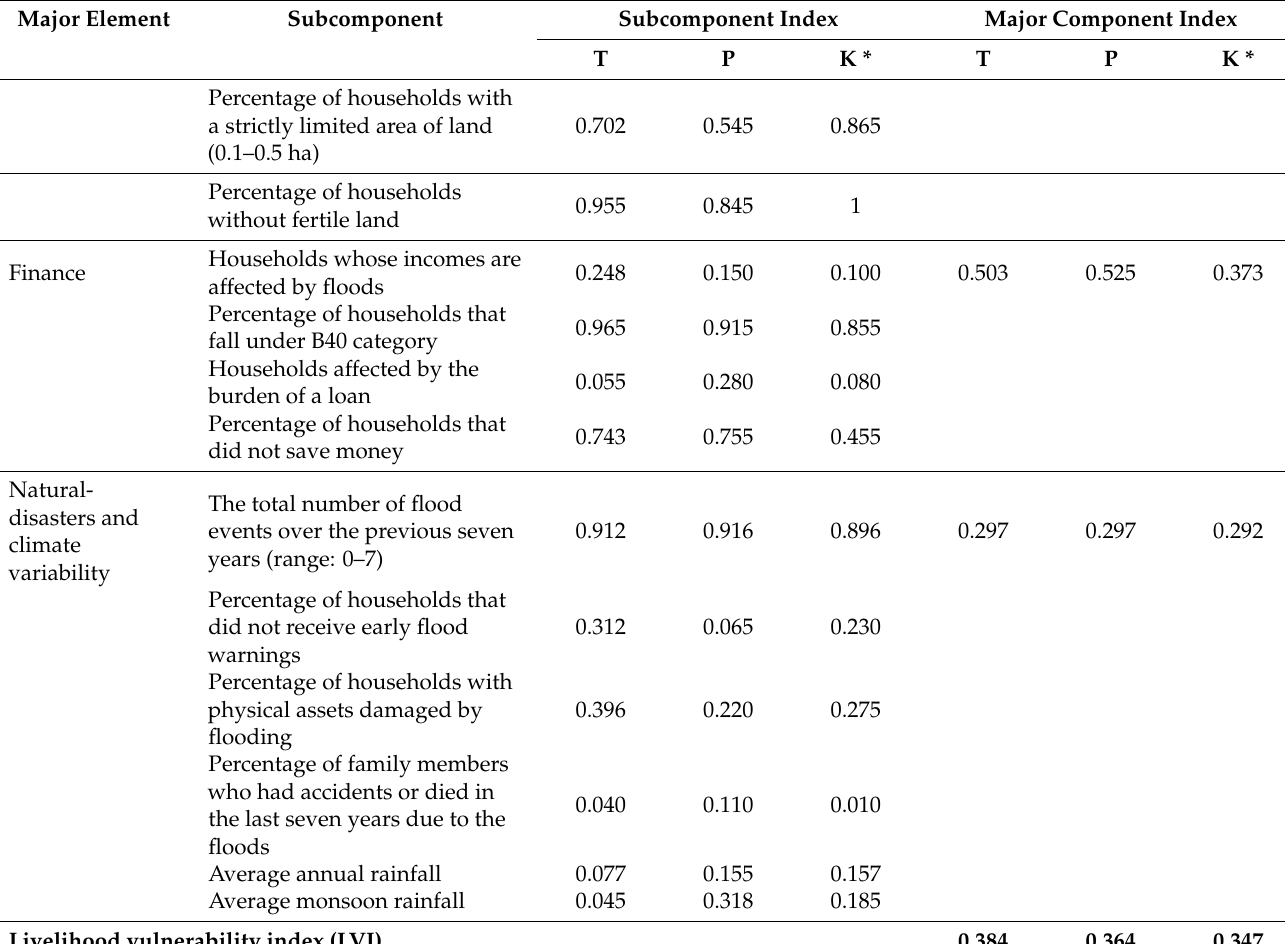
Table 8. Indexed subcomponents, main components, and total LVI for the Districts of Temerloh, Pekan and Kuantan. Major